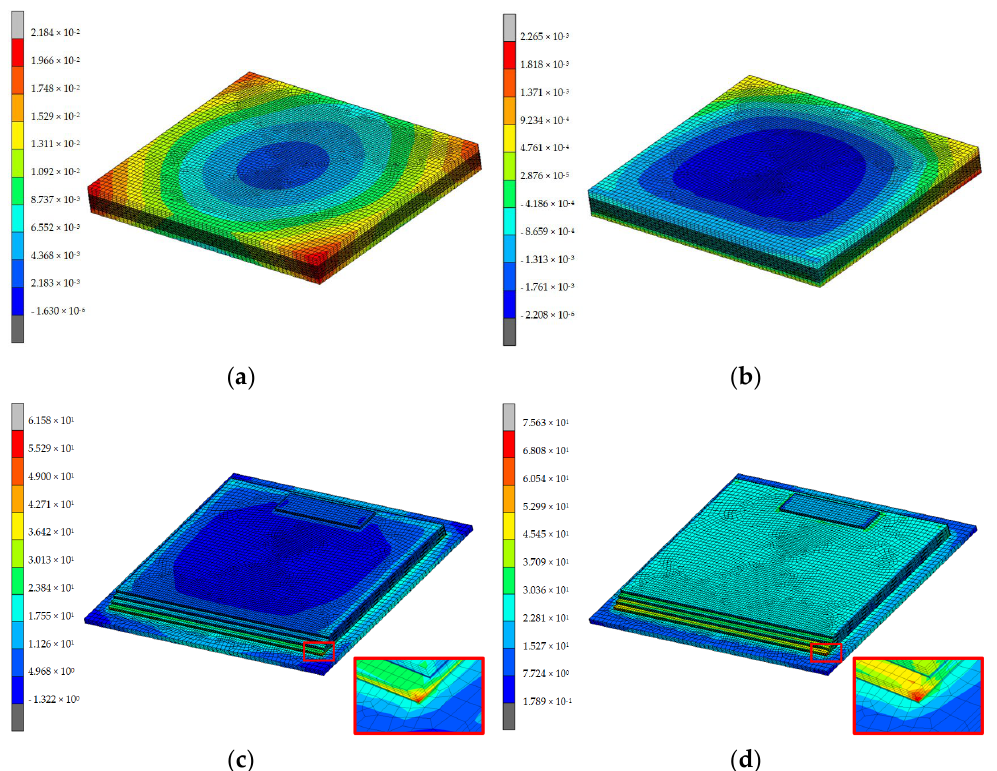
Figure 11. Package deformation and stress cloud picture. ( a ) Package deformation cloud picture at high temperature; ( b ) package deformation cloud picture at low temperature; ( c ) package stress cloud picture at high temperature; ( d ) package stress cloud picture at low temperature.